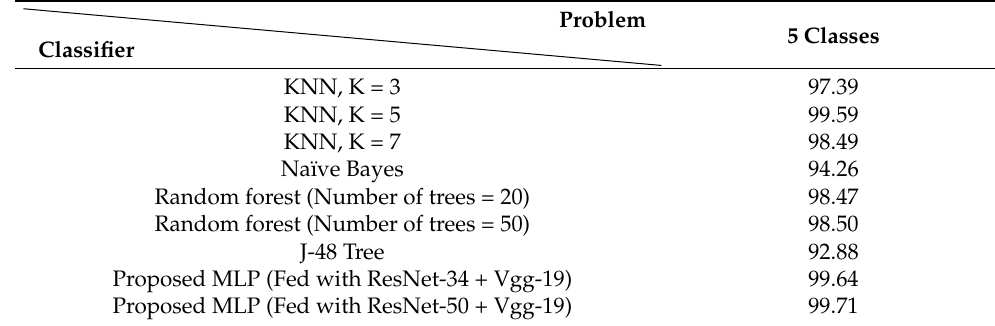
Table 5. The performance evaluation of proposed approach based on different classifiers on the SIPAKMED dataset in terms of accuracy